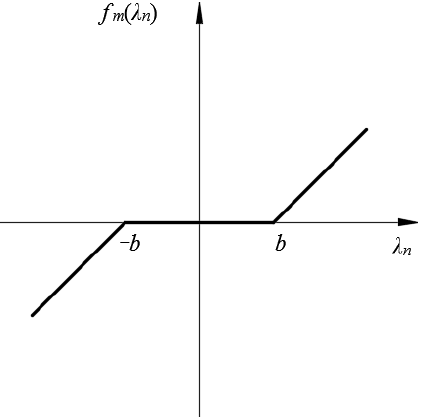
Figure 5. Backlash function.